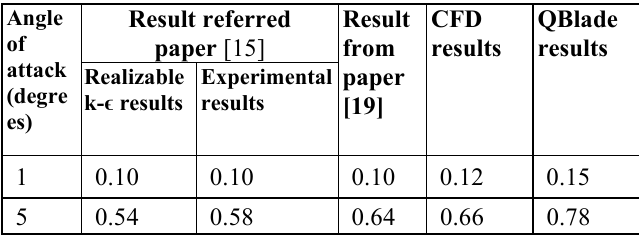
Table 2. Validation results for Cl